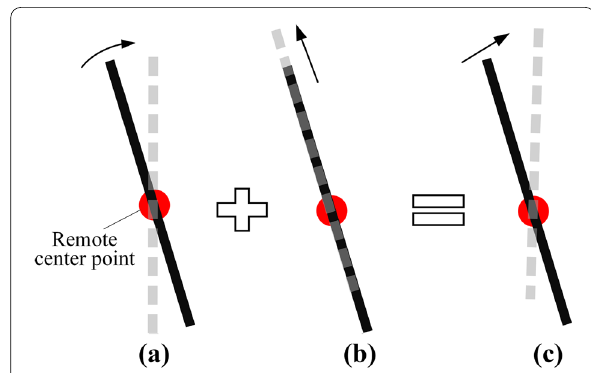
Figure 8 Motion of hysteroscope with RCM